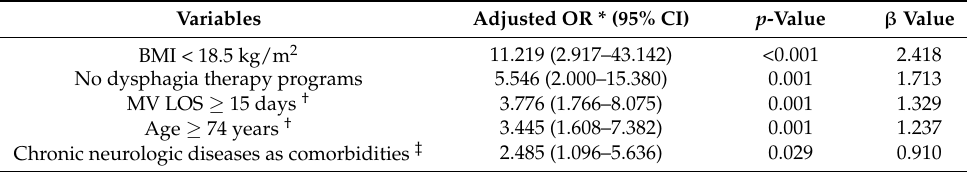
Table 3. Multivariate analyses of factors associated with dysphagia at hospital